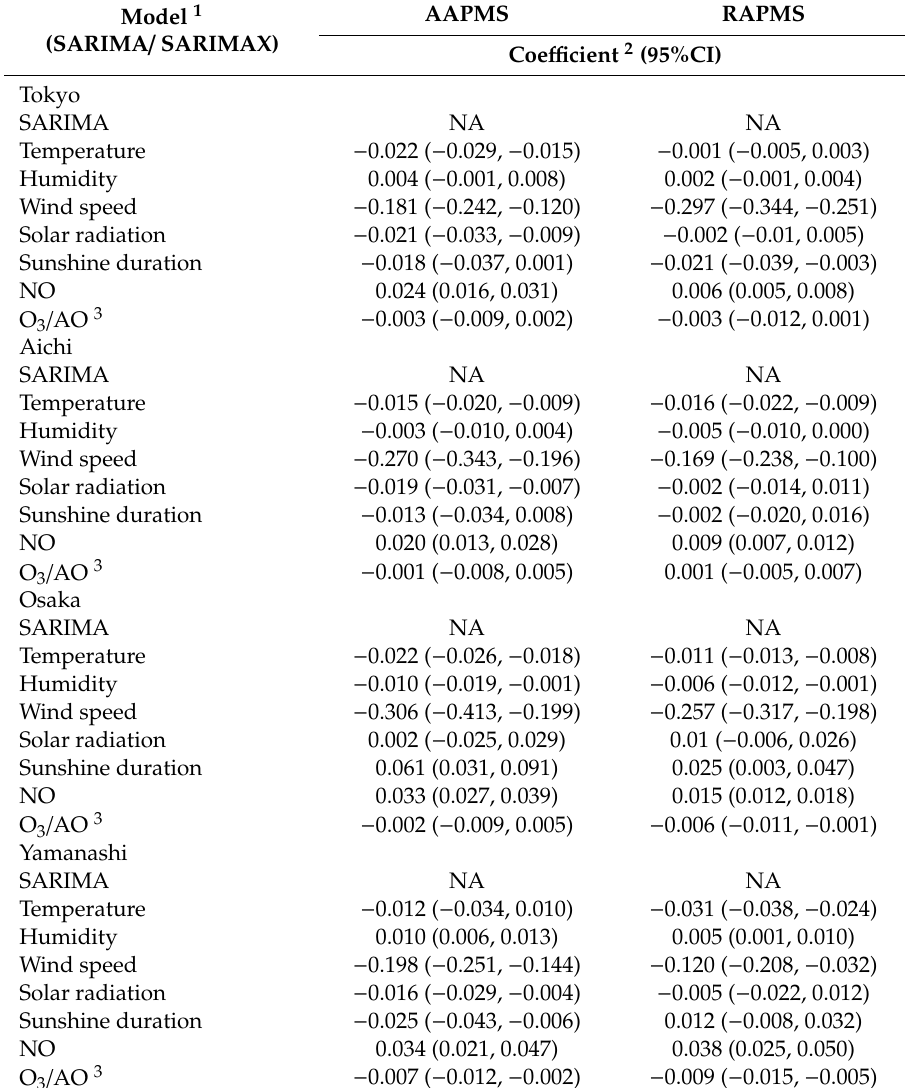
Table 2. Climate and air pollution factors associated with NO 2 concentration in the atmosphere from SARIMAX models at AAPMSs / RAPMSs in Tokyo, Aichi, Osaka, and Yamanashi Prefectures,